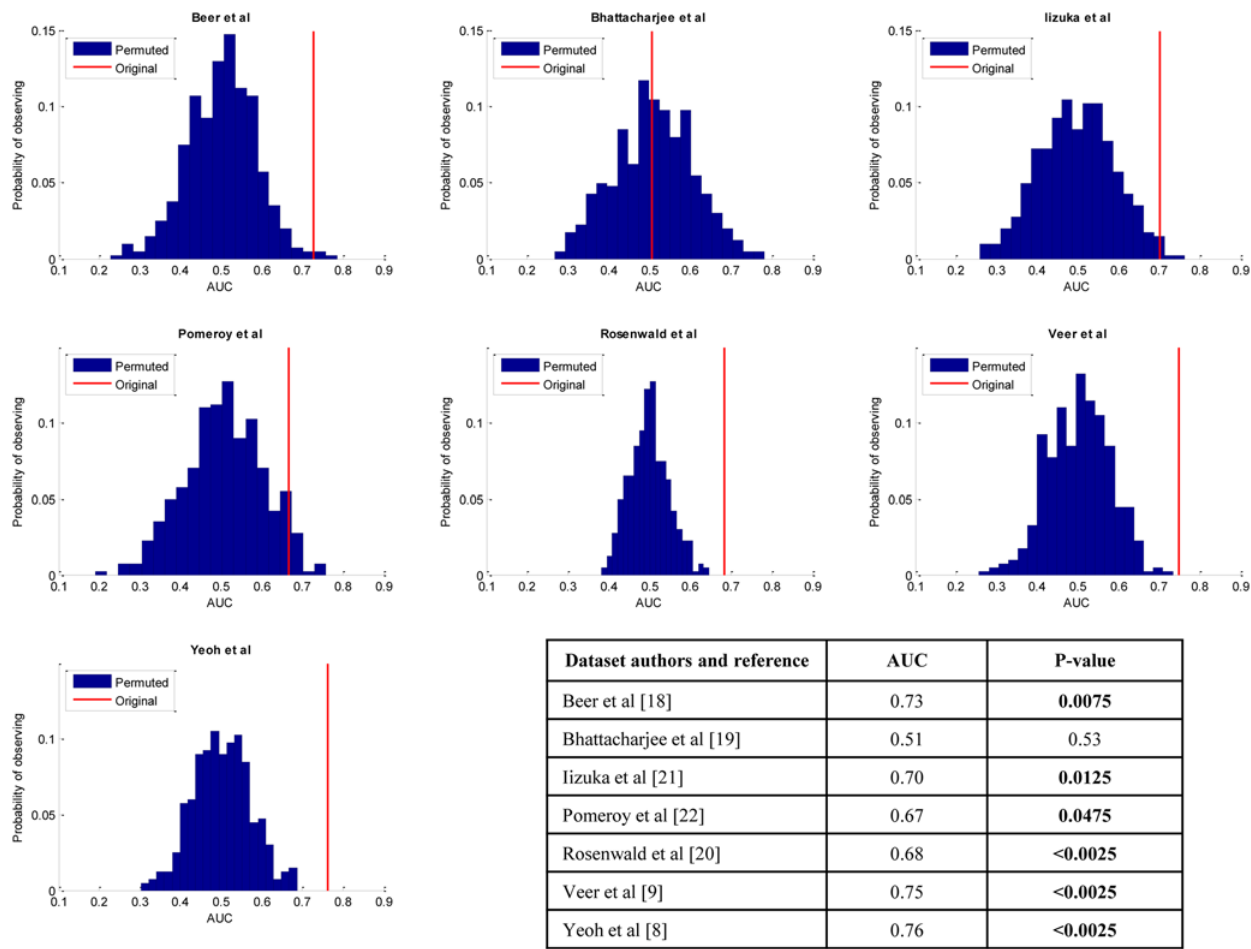
Figure 2. Application of Protocol II to human microarray data. Each histogram is the distribution of the repeated 10-fold cross-validation AUC estimates for each dataset under the null hypothesis ‘‘there is no signal present in the data’’ (as computed by 400 random outcome value permutations). The red line in each graph is the observed value of AUC estimated by the repeated 10-fold cross-validation on the original data. AUC and p-values are shown for each dataset in the embedded table. Bold p-values indicate that the null hypothesis is rejected at the 0.05 level in these datasets.